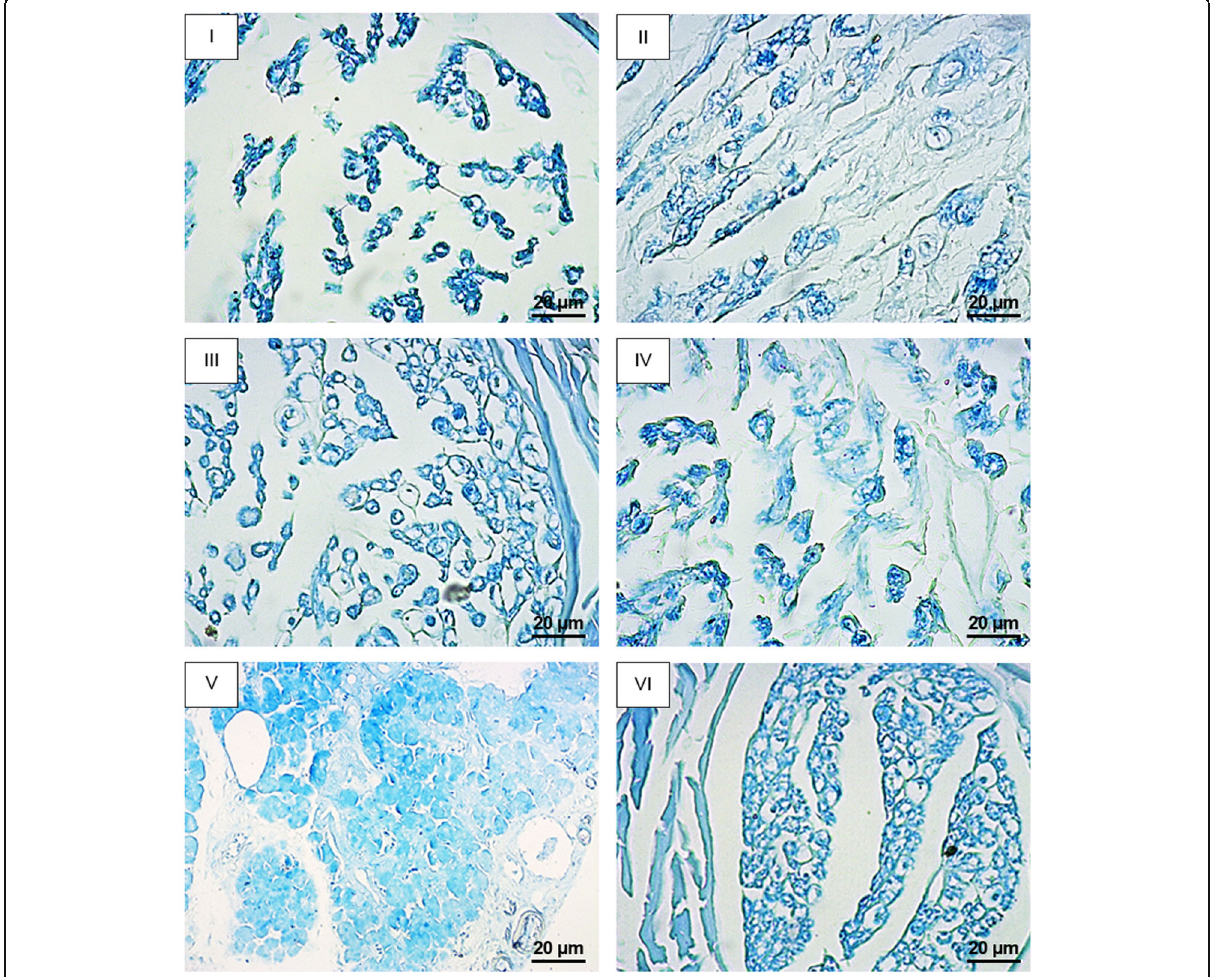
Fig. 3 Luxol fast blue stained nerve cross-sections in different groups. I: silicone tube control; II: hydrogel; III: Fr; IV: NH2-GO; V: Fr + NH2-GO; VI: normal. Reduced axonal regrowth is characterized by increased intercellular space in control